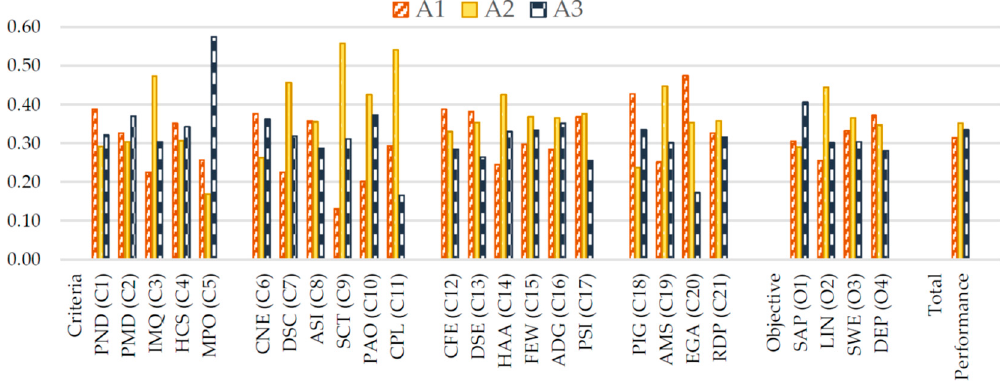
Figure 6. Performance of cities with respect to each objective and